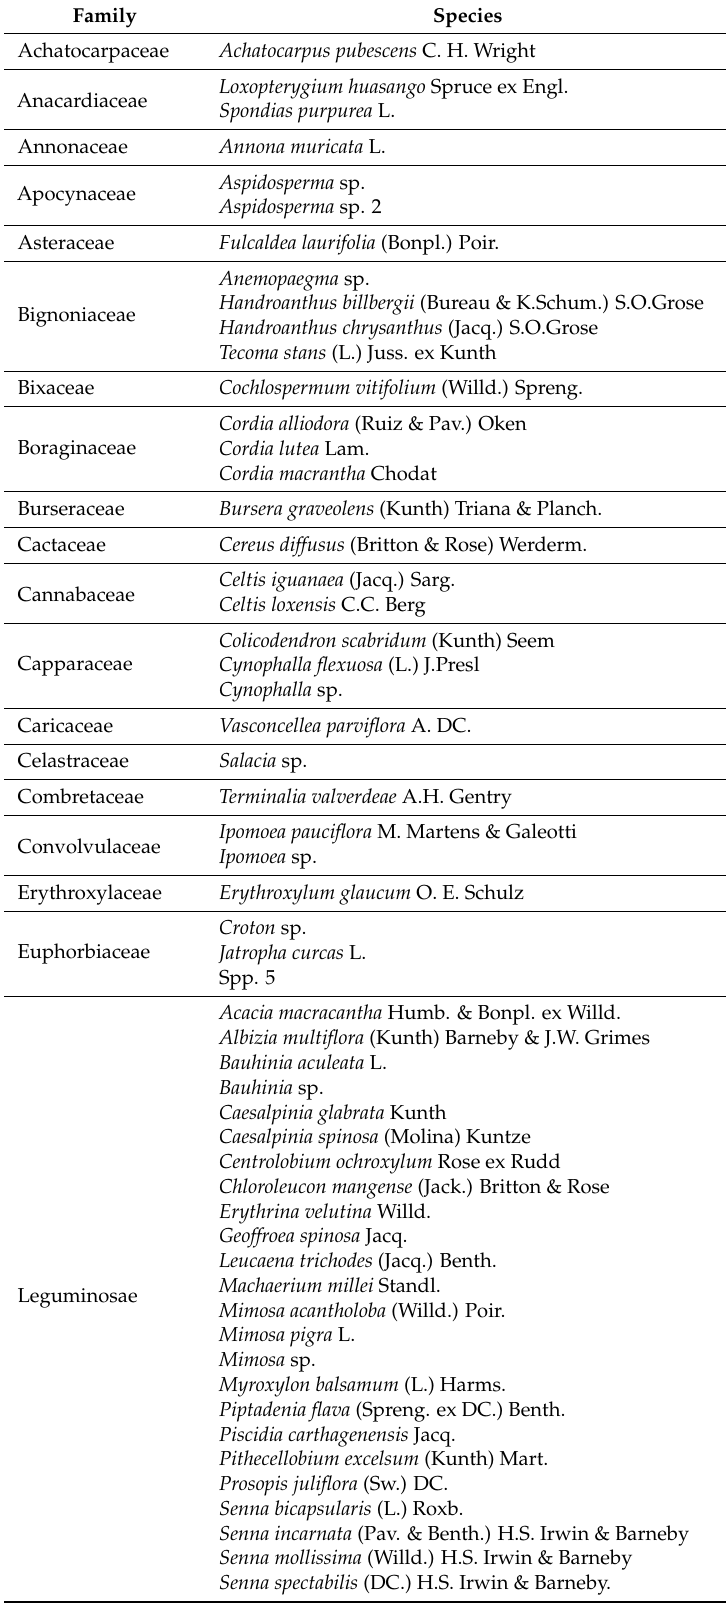
Table A2. List of Species in the Study